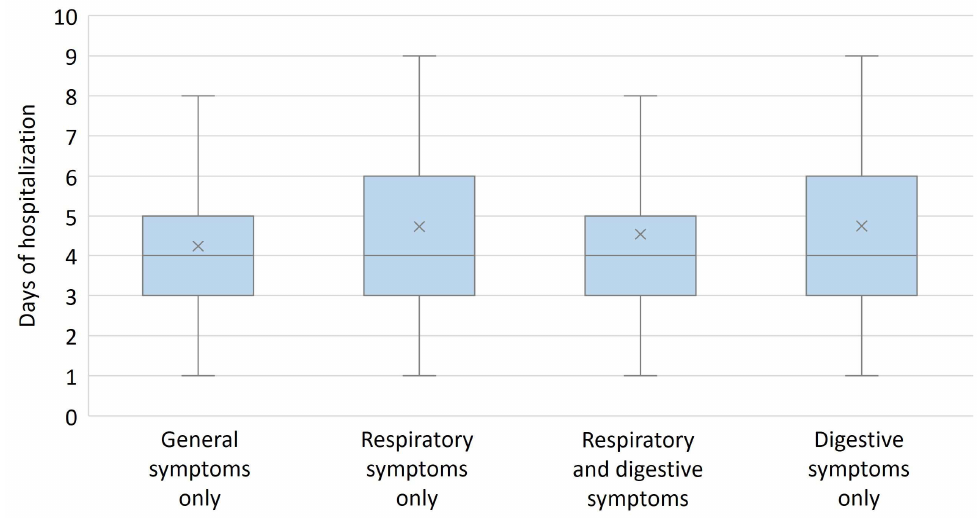
Figure 5. Number of days of hospitalization according to type of symptoms. The length of hospital- ization was not influenced by the type of symptoms and was similar in all groups. Box and whiskers plot represent the 25th and 75th percentiles (box), the median ( × ) and the range (whiskers).